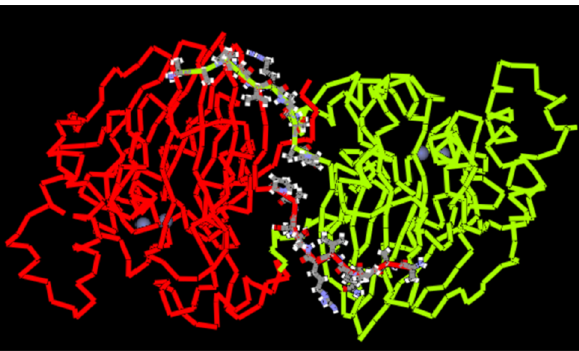
Figure 1. The 3D structure of MPH. The red and green chains are chains A and B of MPH, respectively. The 10 residues at the N-terminus are represented in ball and stick form. The zinc ion is shown as a gray